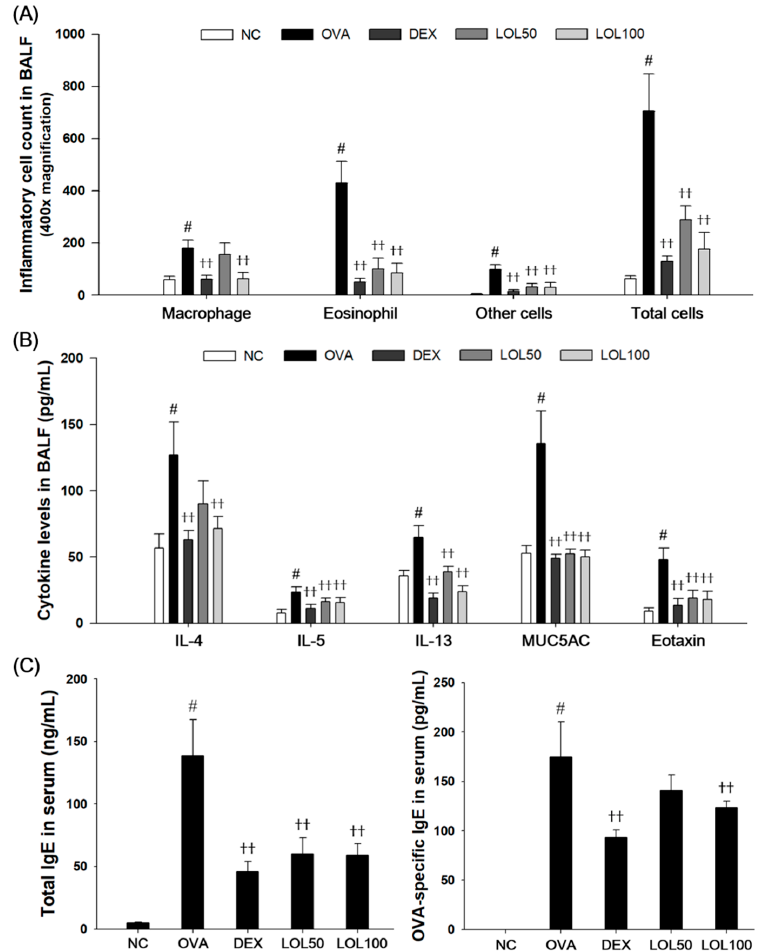
Figure 3. Effects of LOL on inflammatory cell number, Th2 cytokines, eotaxin, MUC5AC, total